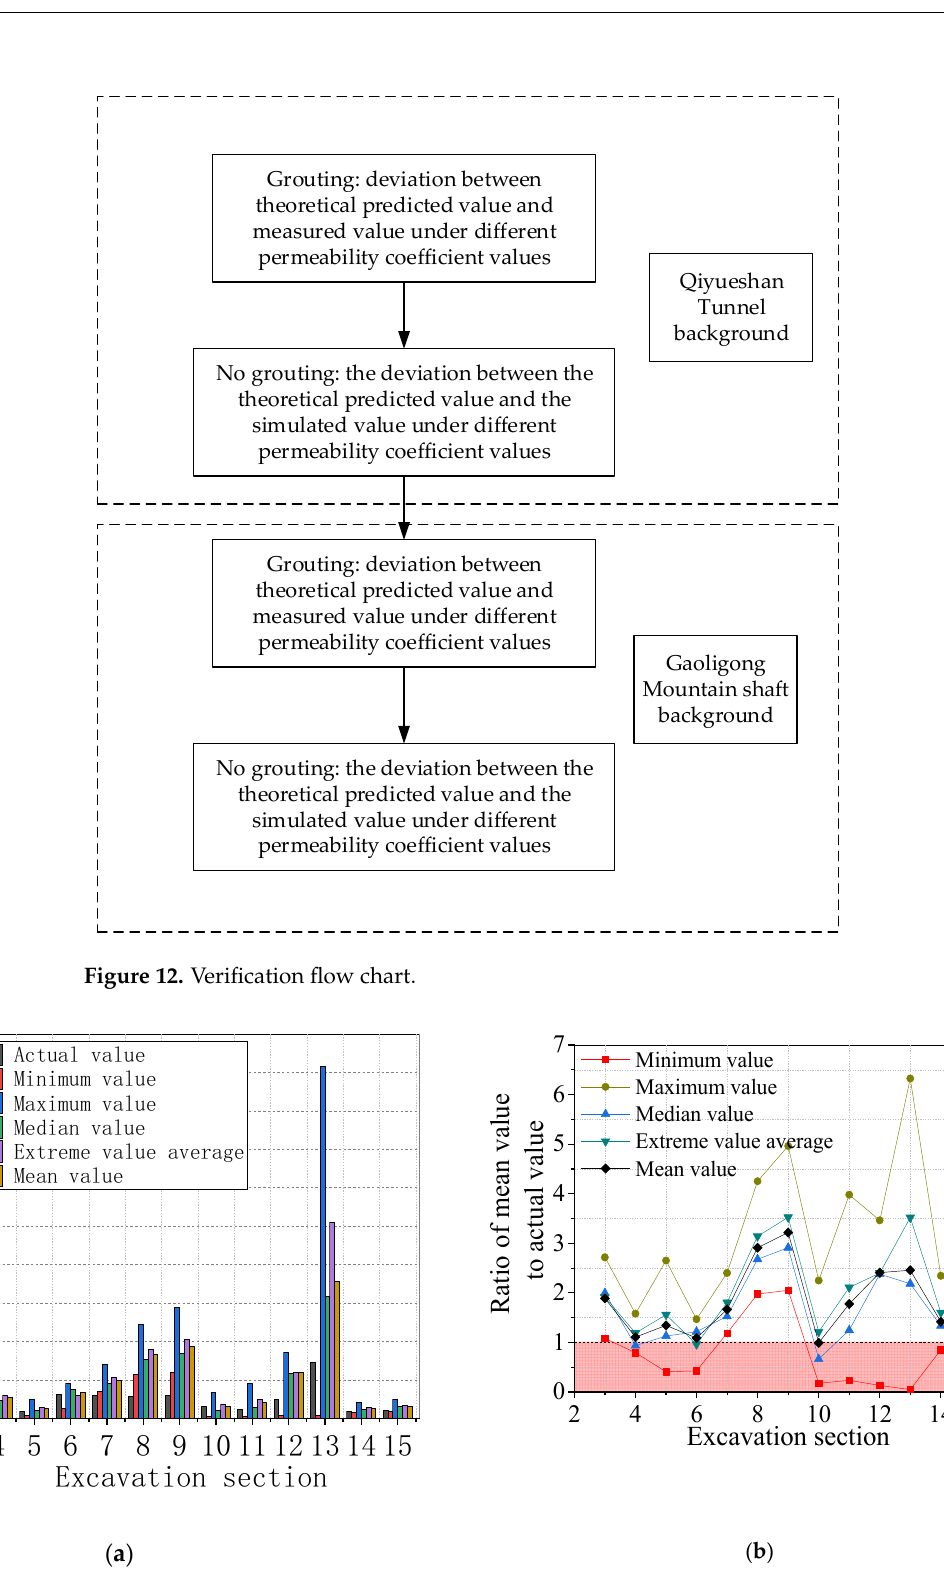
( b ) Figure 14. Calculation model diagram. ( a ) Model size drawing, ( b ) Area of random distribution of permeability coefficients outside of grouting. Meanwhile, the water influx is calculated using a great value when the error is the largest, the size of the error is inversely proportional to the uniformity of the permeability coefficient taken. It is true that the use of very small values of the permeability coefficient